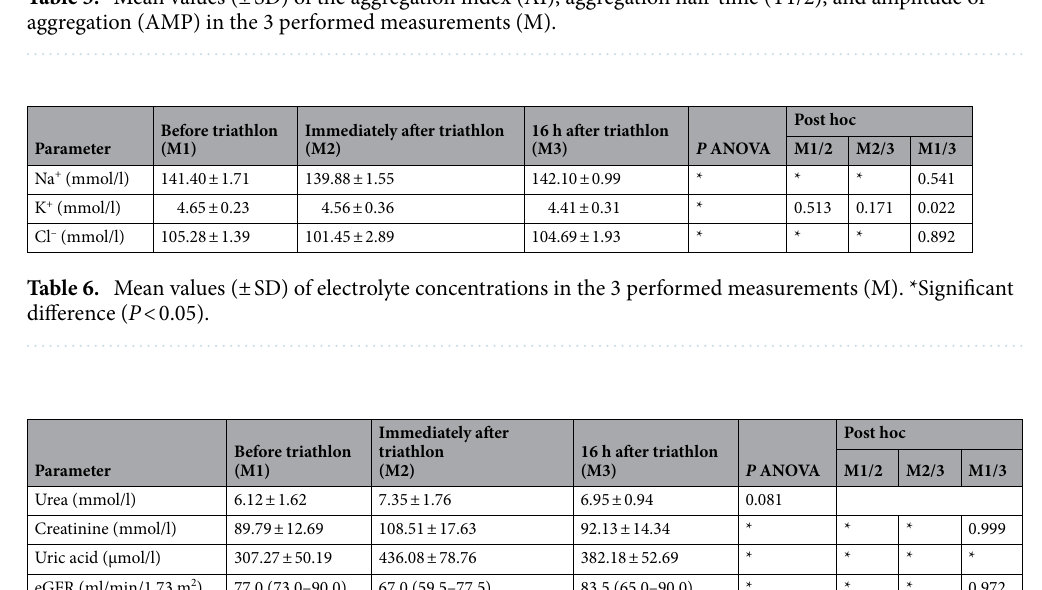
Table 5. Mean values (± SD) of the aggregation index (AI), aggregation half-time (T1/2), and amplitude of aggregation (AMP) in the 3 performed measurements (M).